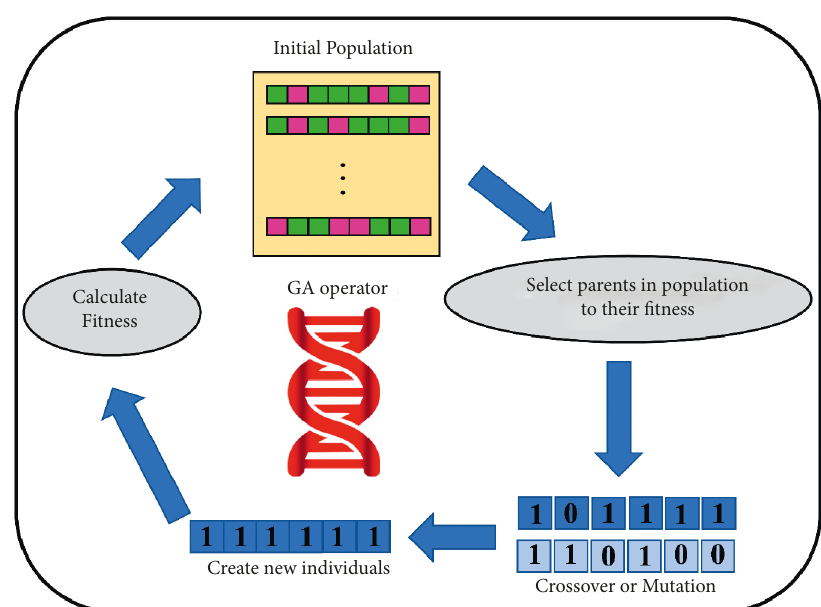
Figure 3: Schematic diagram of GA cycle.